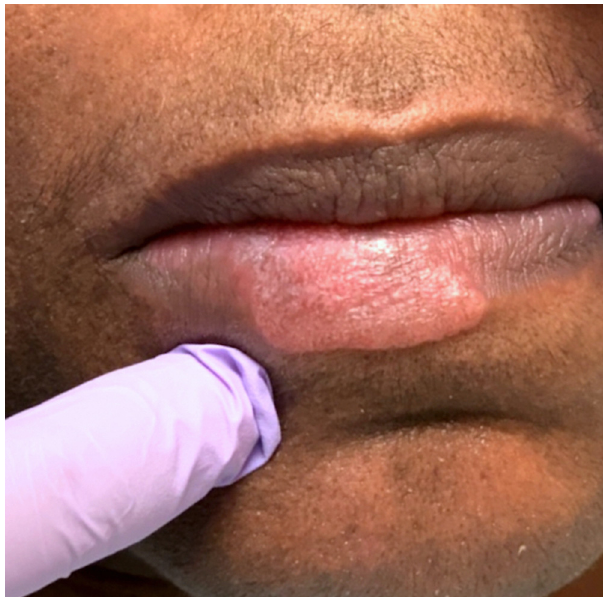
Fig. 1. Lower lip lesion. Pink plaque-like lesion with a corrugated surface is noted on the lower lip.